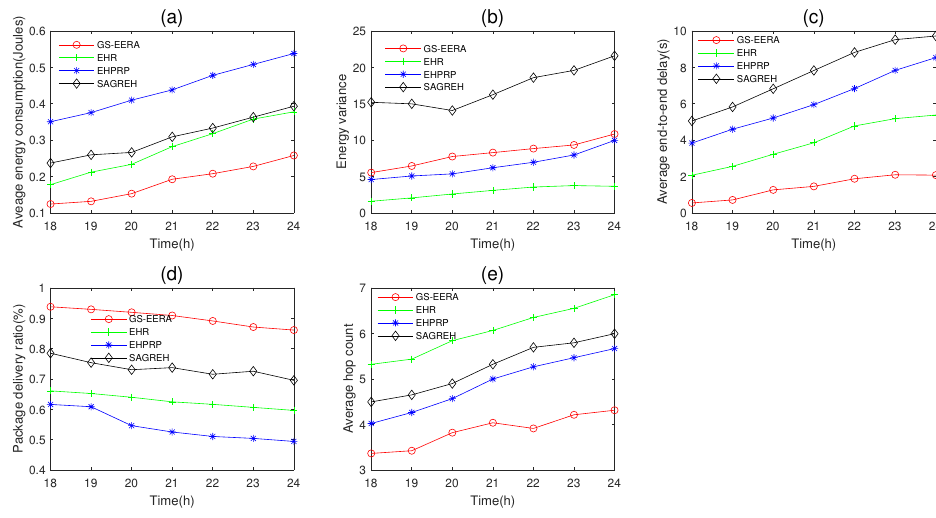
Figure 15. The performance change with time. ( a ) average energy consumption, ( b ) energy variance, ( c ) average end-to-end delay, ( d ) packet delivery ratio and ( e ) average hop